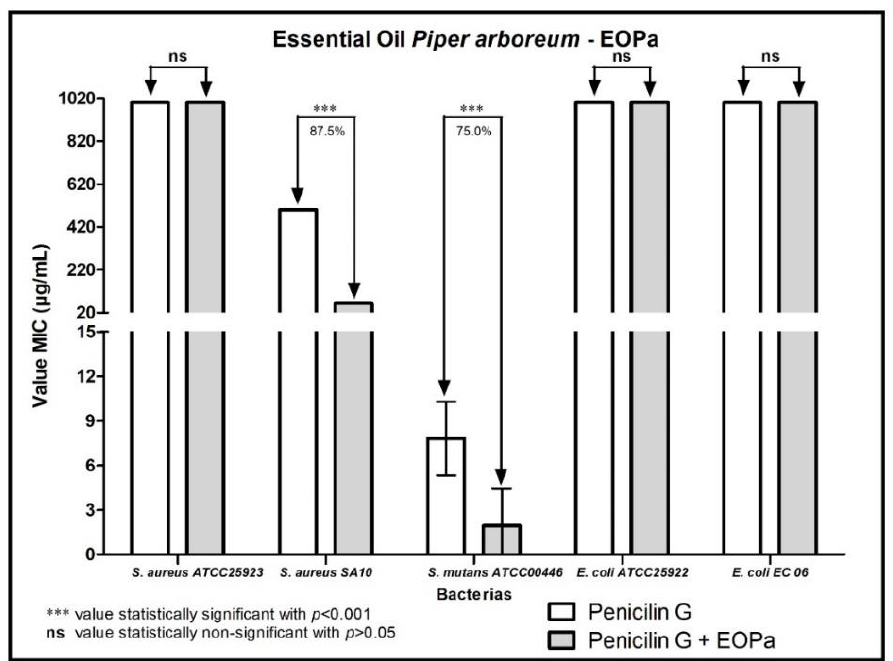
Figure 4. Evaluation of the modulatory activity of EOPa combined with gentamicin against bacte- rial strains.